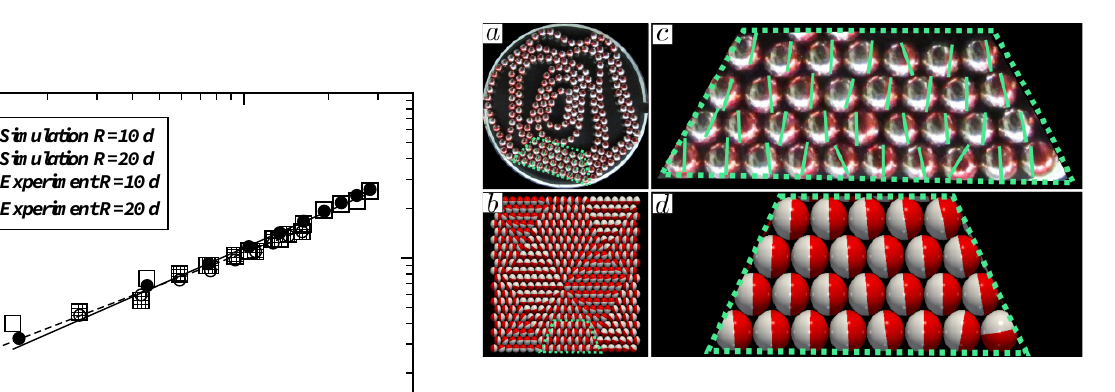
Figure 5. Lowest energy configuration of a triangular lattice for ( a ) experiment injecting the chain through the center of the cav- ity and ( b ) Monte Carlo simulation of dipoles on a triangular net- work with periodic boundary condition in both directions (top- bottom and right-left). Here, the dipoles can only rotate (not move) to reach the lowest energy configuration. In both cases, the dipoles are identified by painting in red the hemisphere (the heads of the dipoles) into which the dipole vector points. For the sake of clarity, we have added green lines along the direction of the dipoles on the experimental images as shown in ( c ). (d) For better visualization we magnify part of the Fig. 5 (b). We surround with a dashed green line a region of the packing, exper- imentally and numerically obtained where the magnetic dipole orientations exhibit considerable similarity. Those regions are shown in c and d , respectively. In these selected regions the pat- tern of the magnetic dipoles corresponds to the lowest energy